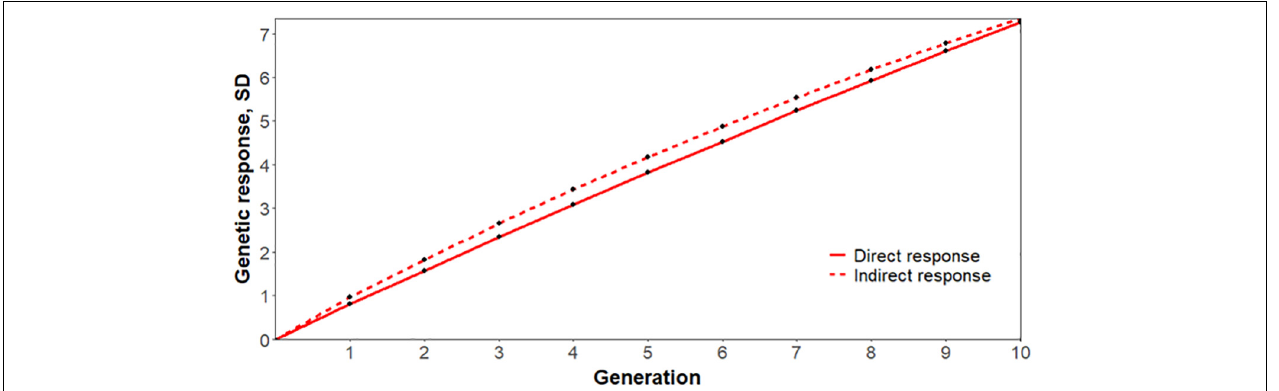
FIGURE 4 | Simulated response to selection for increased number of piglets born alive (NBA) in Landrace sows after 10 generations based on (indirect) or not (direct) antibody response to porcine reproductive and respiratory syndrome virus infection, measured as sample-to-positive (S/P) ratio. The y - and x -axis represent the response to selection in genetic standard deviations and generations, respectively. Direct and indirect response to selection are represented by solid and dashed lines, respectively, assuming 5% selection intensity, using the genetic parameters obtained in this